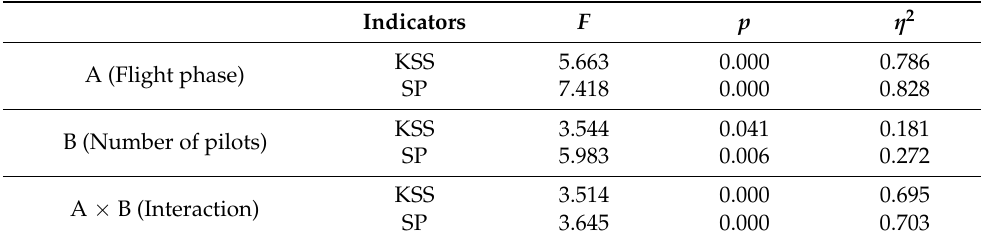
Table 3. Analyze results of the subjective self-assessment. Indicators F p η 2 A (Flight phase)